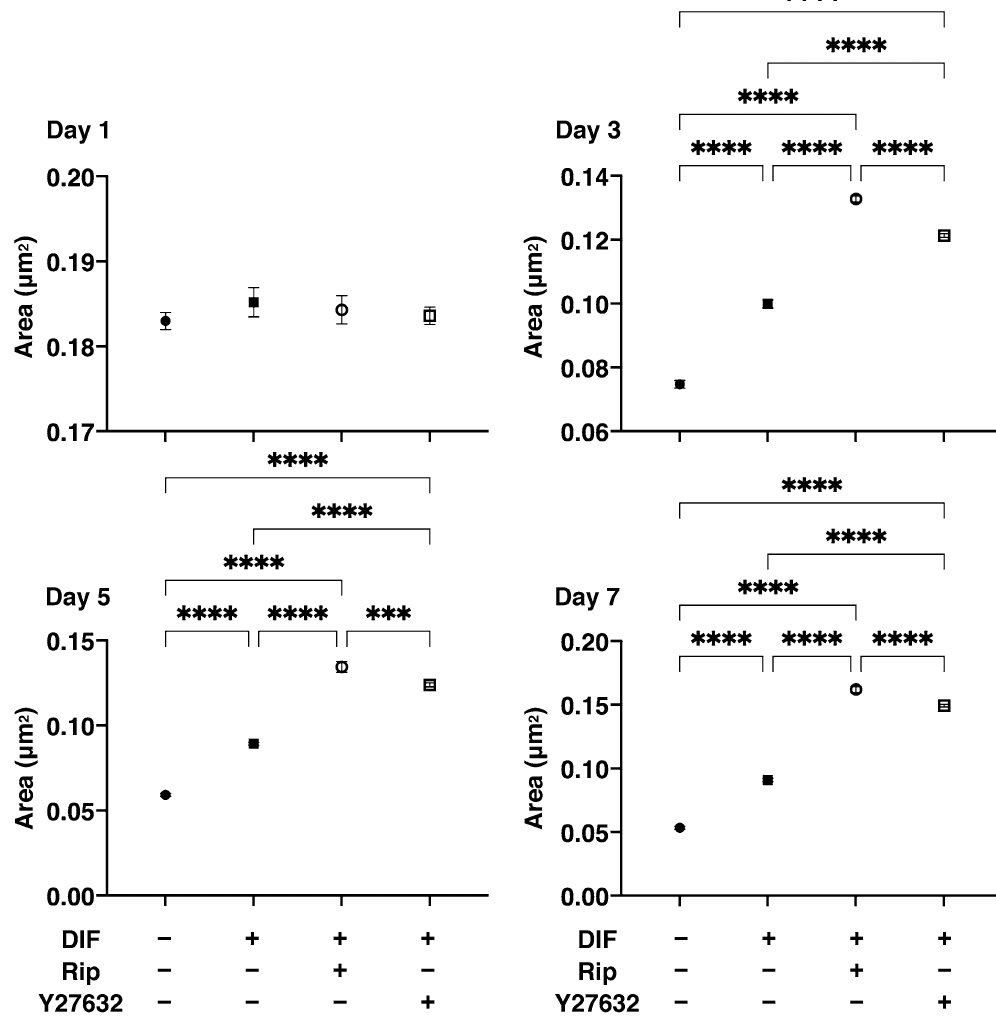
Figure 4. Effects of ROCK-i on area sizes of the 3T3-L1 3D organoids during adipogenesis. The mean area sizes (μm 2 ) of the 3D organoids of 3T3-L1 preadipocytes (DIF−, closed circles) and their adipogenic differentiation (DIF+ , closed squares) without or with 10 µM Ripasudil (Rip, open circles) or Y27632 (open squares) were measured. Fluctuations of those during 7-day culture were plotted (left panel) and those at Day 7 were compared among experimental groups (right panel). All experiments were performed in triplicate using fresh preparations, each consisting of 16 organoids. Data are presented as arithmetic means ± standard error of the mean (SEM). **** P < 0.001, and other pairs were not statistically significant (ANOVA followed by a Tukey’s multiple comparison